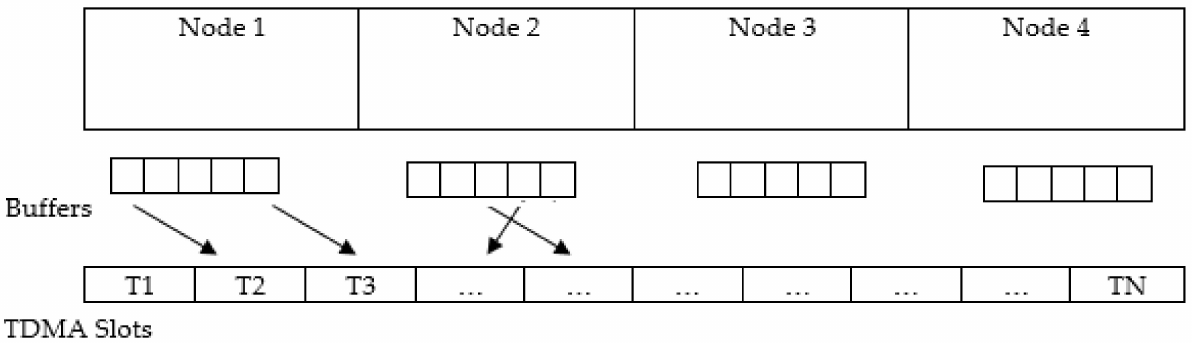
Figure 6. E5-Aggressive TDMA scheduling and buffer